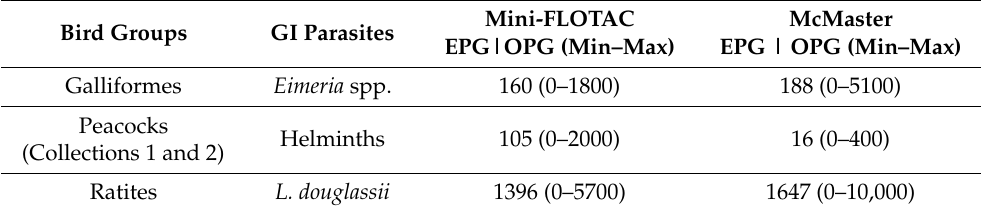
Table 3. Mini-FLOTAC and McMaster shedding data obtained for each bird